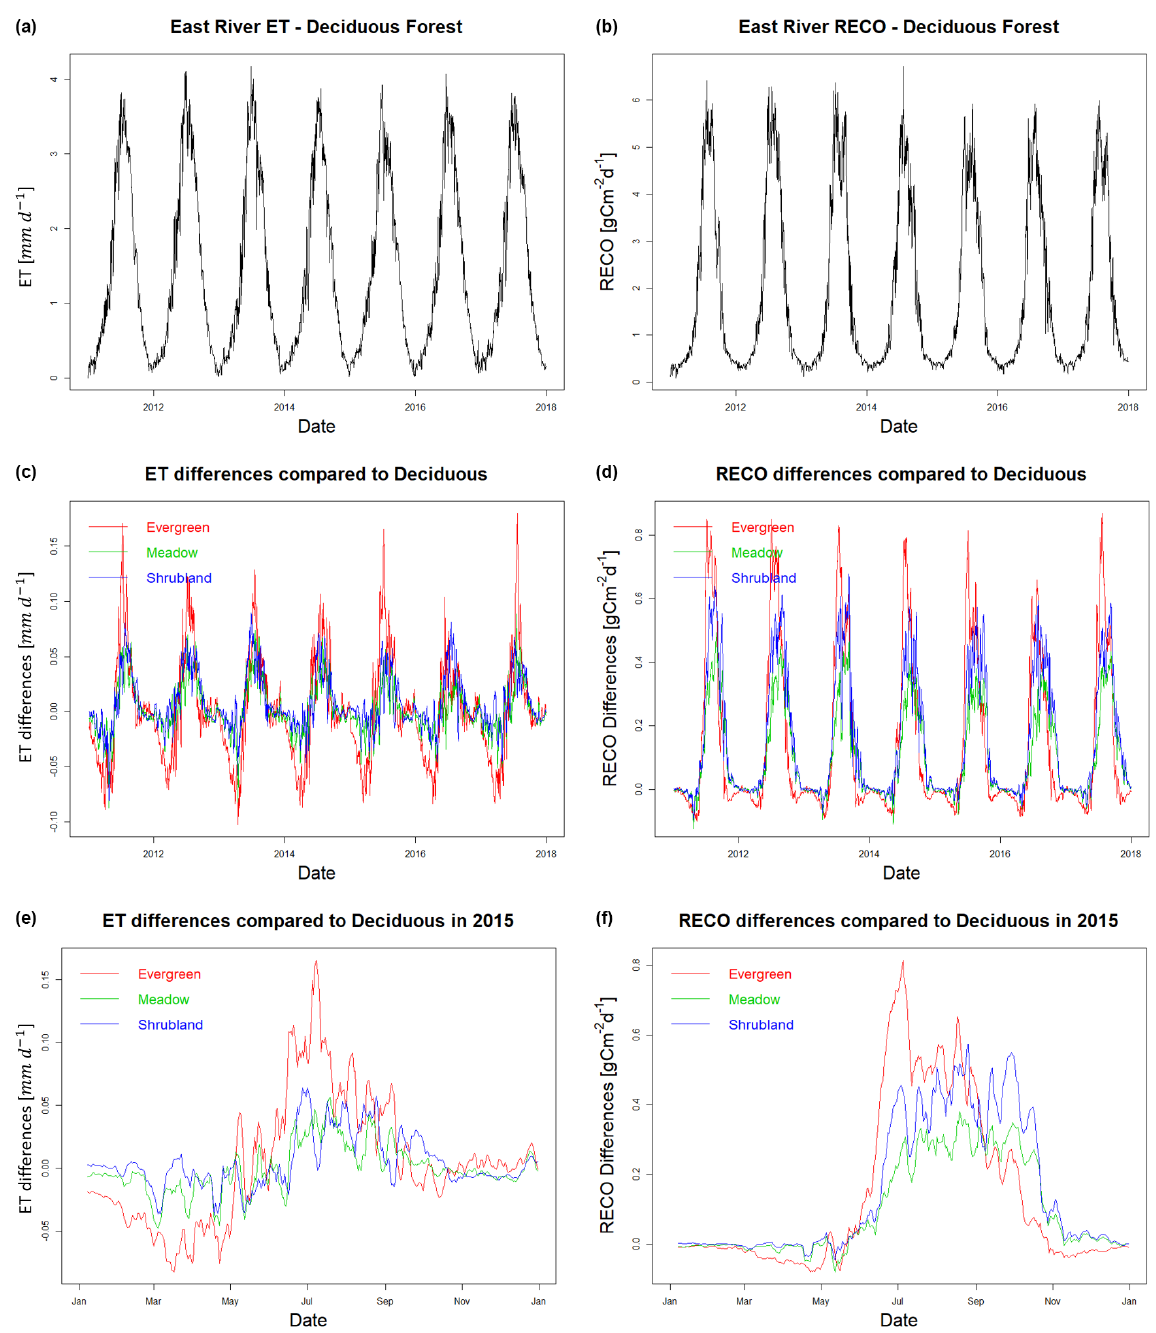
Figure 9. ET (a) and R eco (b) estimation for the deciduous forest site DF1 at the East River Watershed. Panels (c) and (d) show the differences in ET and R eco among various vegetation types and deciduous forest. Red, green, and blue lines represent the differences in evergreen forest, meadow, and riparian shrubland compared to deciduous forest. Panels (e) and (f) zoom into 2015 to better display seasonal